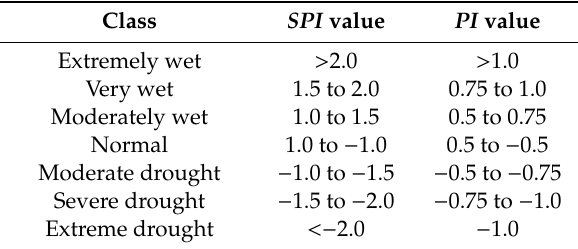
Table 3. SPI and suggested PI